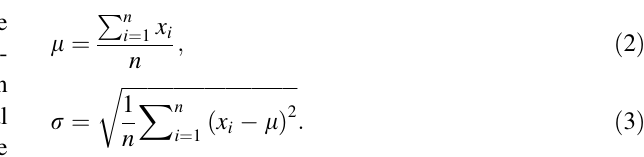
Table 1 Range of overall feature values for normal/subhealth data Parameter state